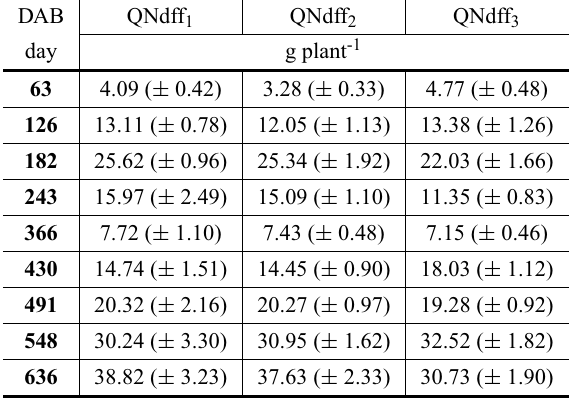
Different ways of calculating QNdff: QNdff 1 = sum of in- dividual compartments; QNdff 2 = use of equation (3) with weighted averages of C N and A N ; QNdff 3 = use of equation (3) with data of C N and A N from leaves of productive branches. (DAB = days after beginning, starting Sept 1, 2003).